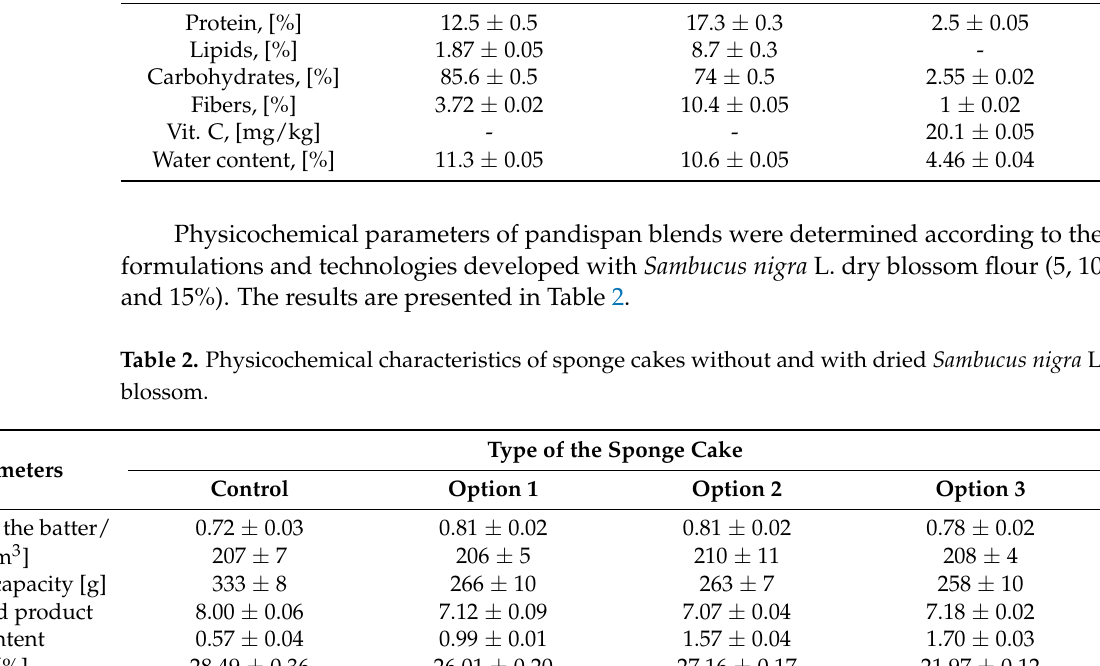
Table 1. Chemical composition of the flours used in the sponge cakes. Wheat Flour Type